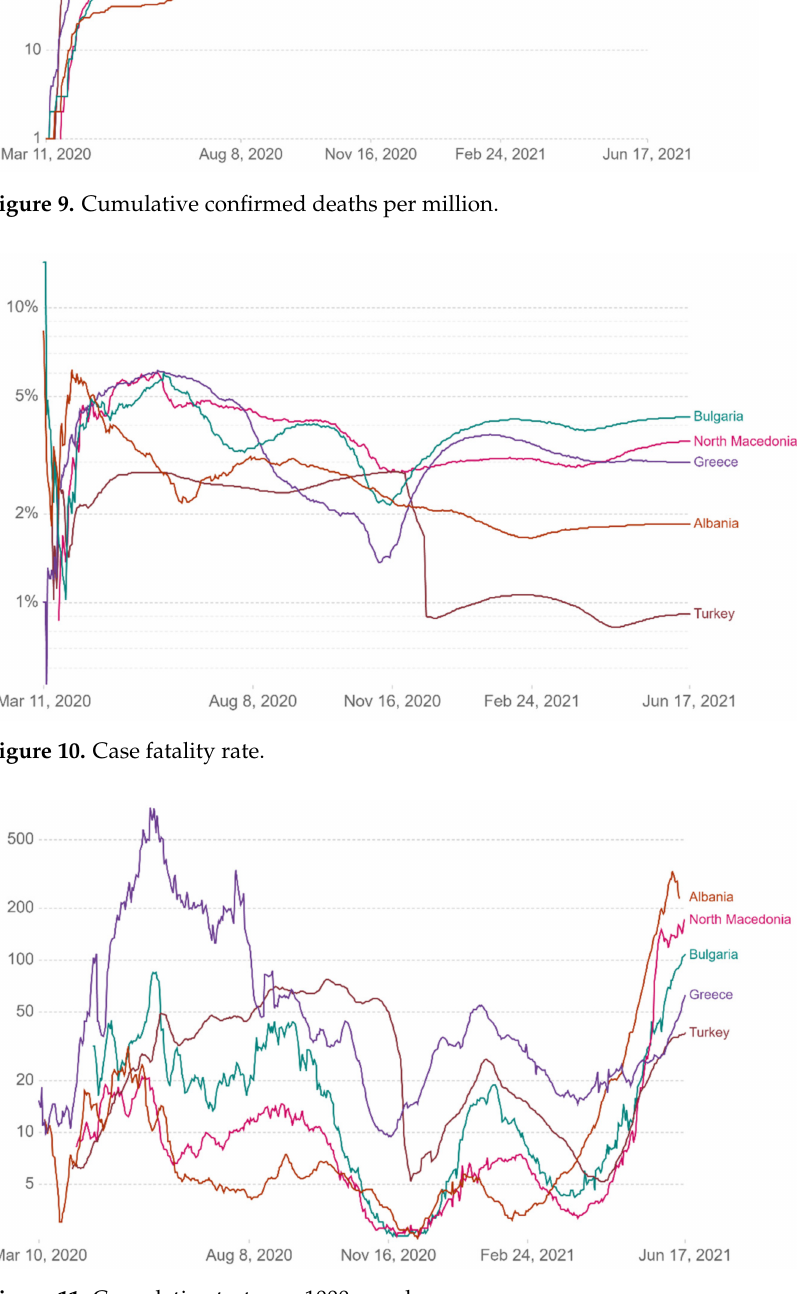
Figure 11. Cumulative tests per 1000